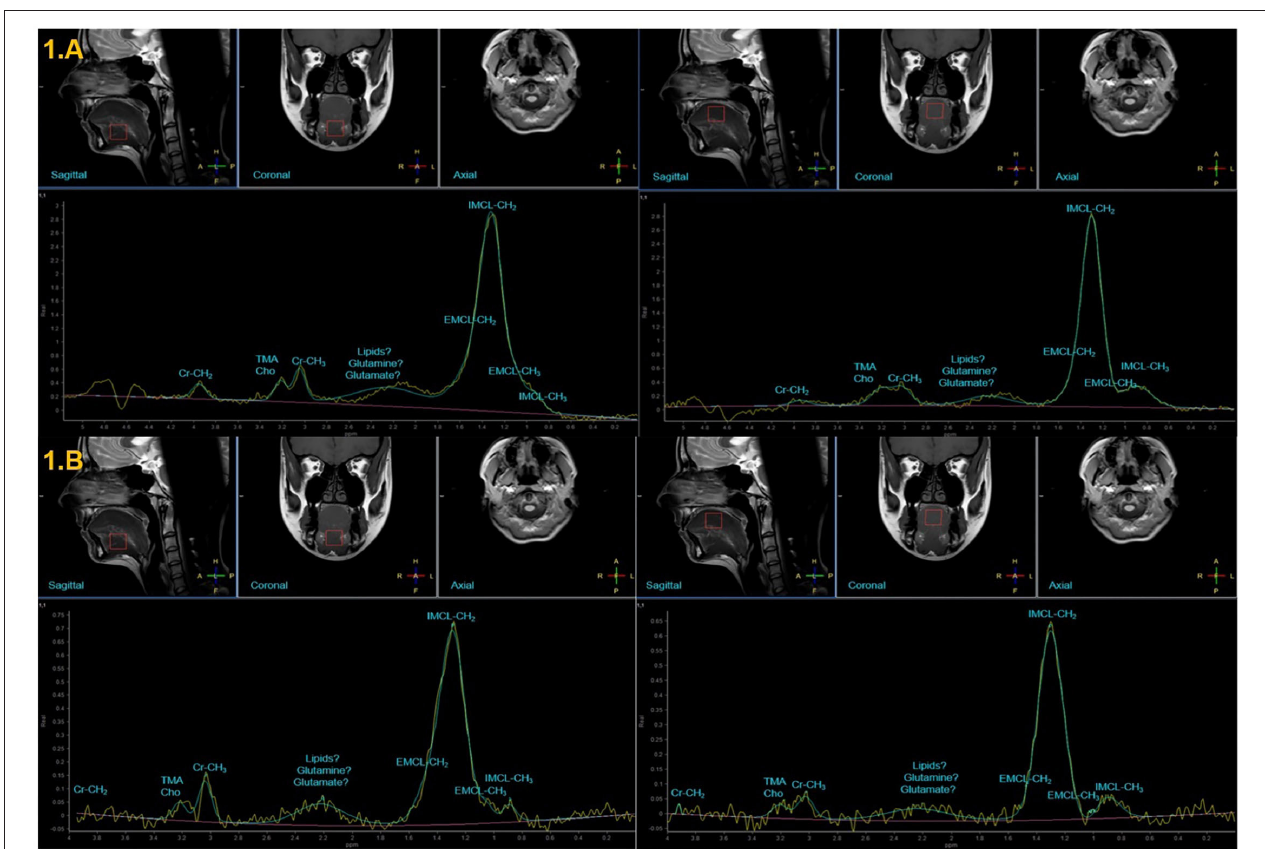
FIGURE 1 | Representative MR images illustrating 1 H-MRS voxel placement at the medial superior and the anterior inferior parts of the tongue in healthy subjects and their corresponding representative MR spectra measured at TE of 35ms (A) and TE of 144ms (B) .